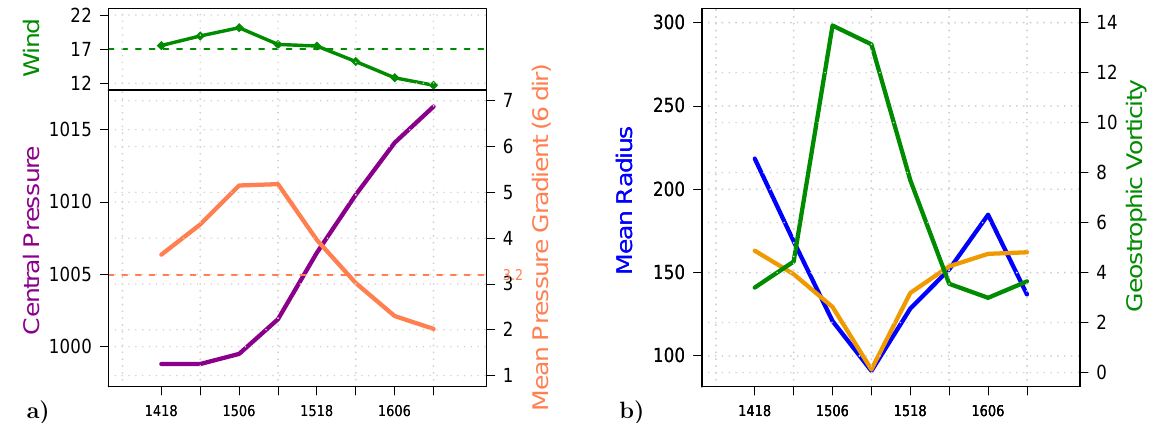
Fig. 6. Evolution over time of (a) gradient wind (ms − 1 ) in green (top) and central pressure (hPa) in violet + mean pressure gradi- ent (10 − 2 hPakm − 1 ) in orange (bottom); (b) mean radius (km) in blue + mean warm core radius (km) in orange + geostrophic vorticity (10 − 4 s − 1 ); for 1995 event.